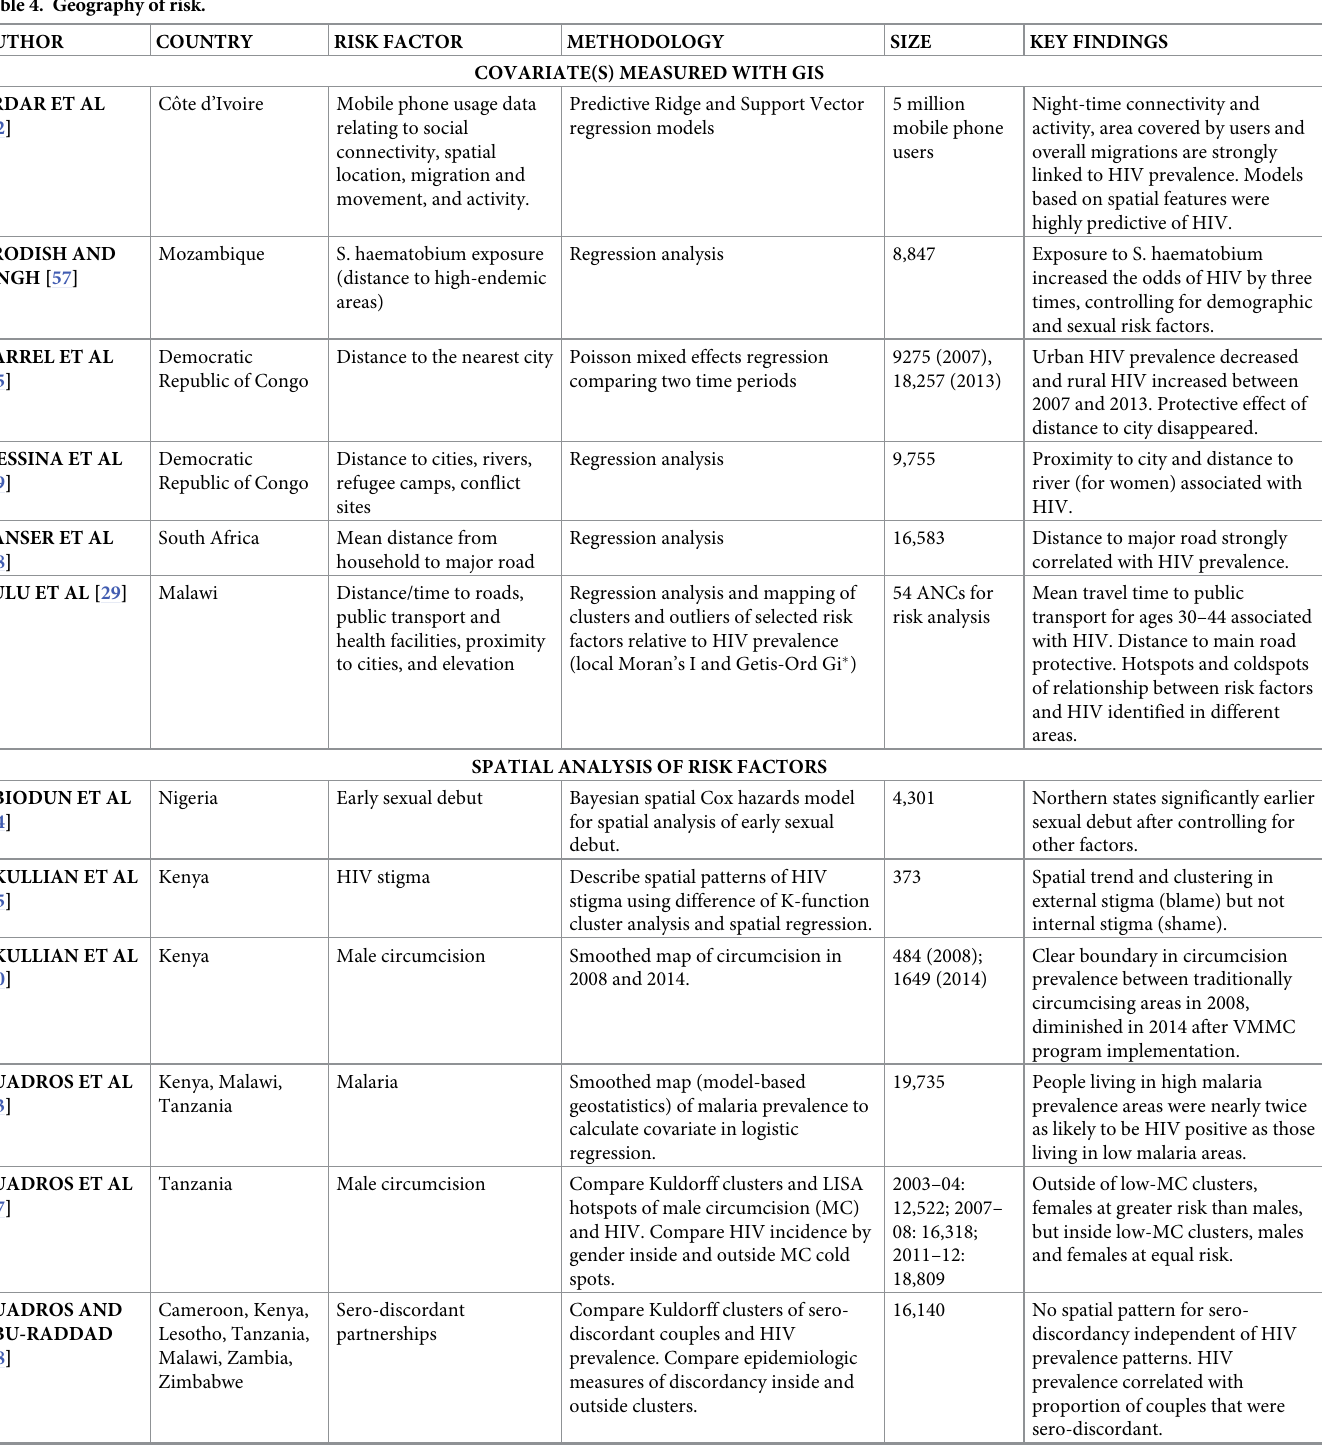
Table 4. Geography of